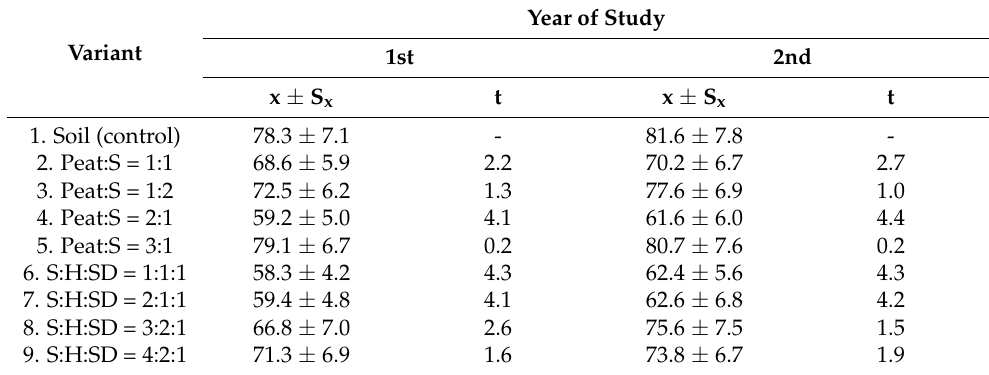
Table 2. Survival rate of English oak seedlings in containers with different substrate composition (in %)—statistical data